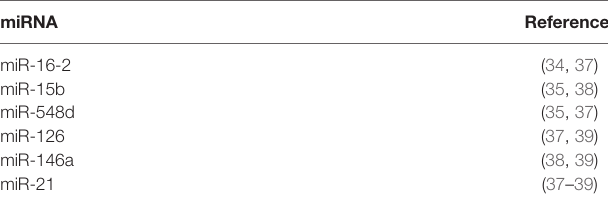
TABLE 2 | Six COVID-19 miRNA biomarkers identi fi ed by at least two studies. miRNA